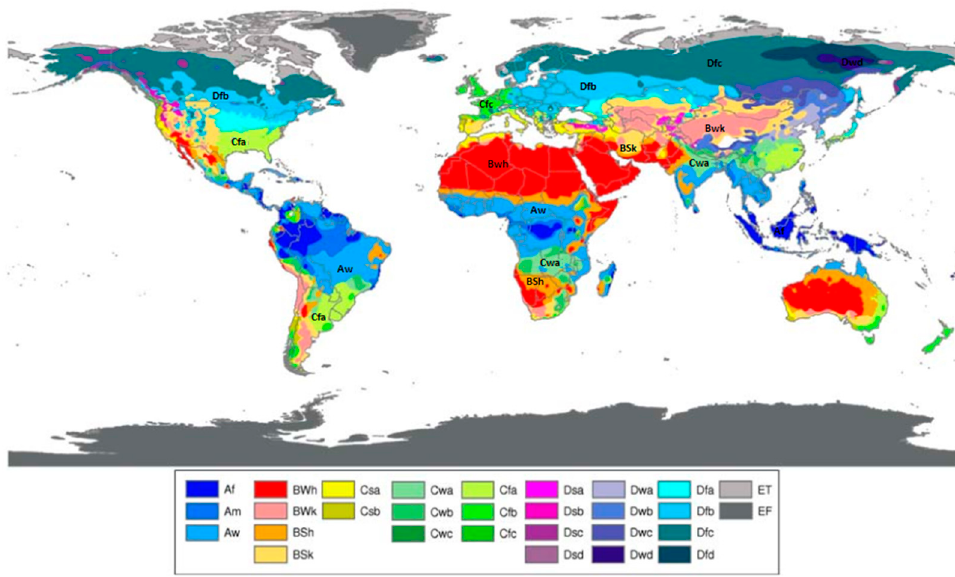
Figure 4. Koppen-Geiger climate type map of the landmass of the Earth [45].